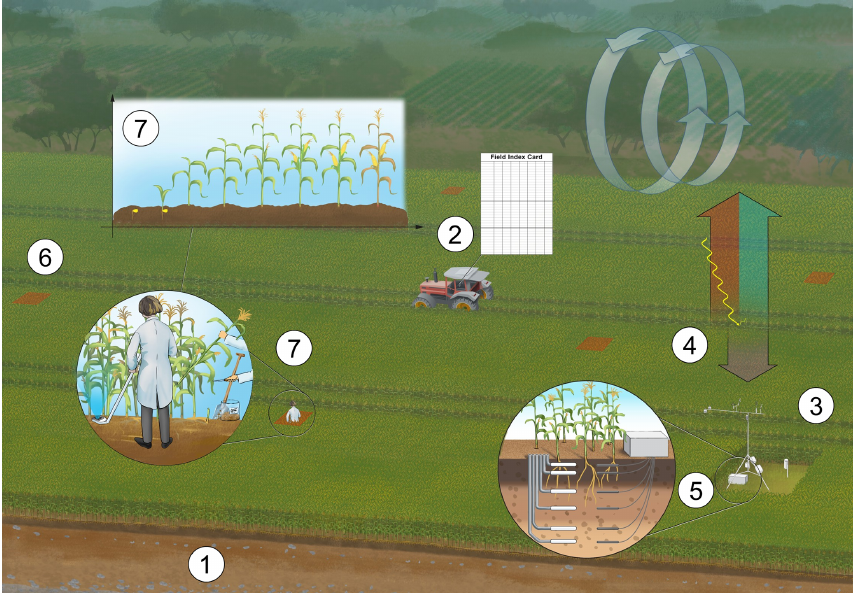
Figure 2. Schema of the measurement campaign at the research sites: 1 – soil profile characteristics; 2 – management and cultivation data (sowing date, harvest date, crop type and variety, fertilization, and pesticide application including amount and type) and soil tillage; 3 – meteorological data (rain and air temperature at 2m height and relative humidity); 4 – soil–/biosphere–atmosphere fluxes using fully equipped eddy-covariance stations for carbon, energy and water vapour flux measurements, as well as wind speed and wind direction; 5 – soil state measurements including water content, temperature and matric potential, soil profile depth permitting at 5, 15, 45, 75, 90 and 130cm soil depth; 6 – five plots per research site for carbon and nitrogen measurements integrated over depths of 0–30, 30–60 and 60–90cm; and 7 – plant performance also determined at the plots (phenology, height and leaf area index; yield; aboveground biomass; and carbon and nitrogen in vegetative and generative biomass). A detailed GIS (geographic information system) data model is included in the dataset including fields, measurements locations and plots. Illustration by Holger Vanselow (http://www.holgervanselow.de/, last access: 13 December 2021).